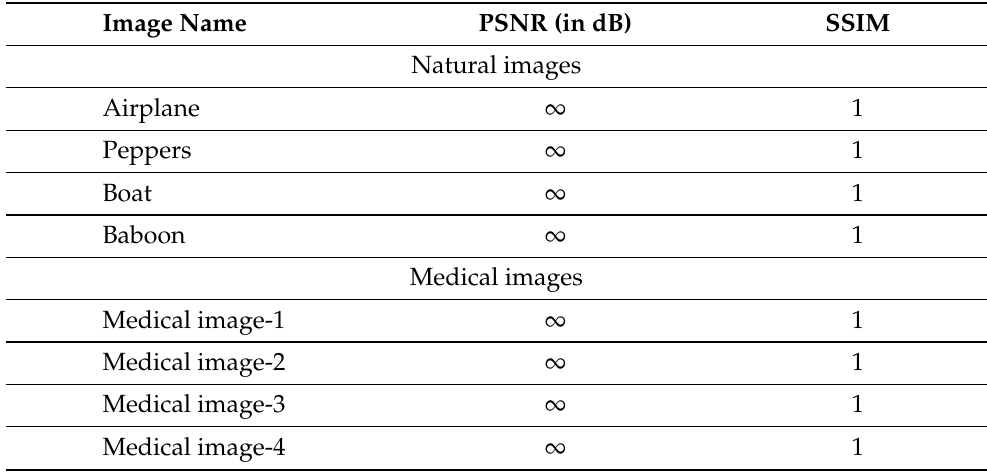
Table 3. PSNR and SSIM observed during image